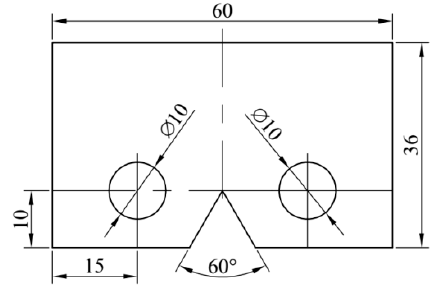
Figure 3. Shape and dimensions of the specimens for Kahn tear tests (mm).